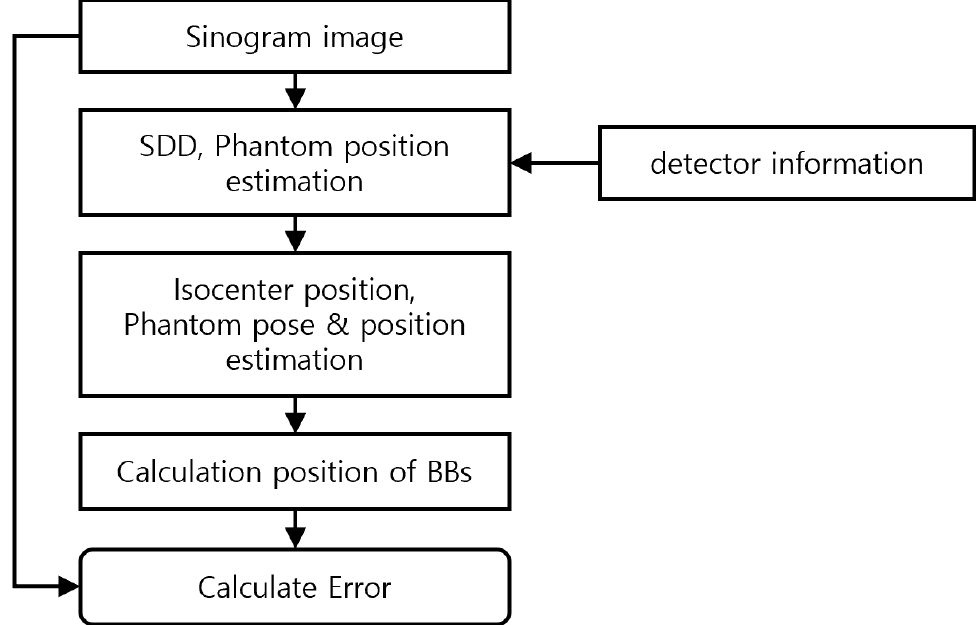
Figure 4. A flowchart of the calibration